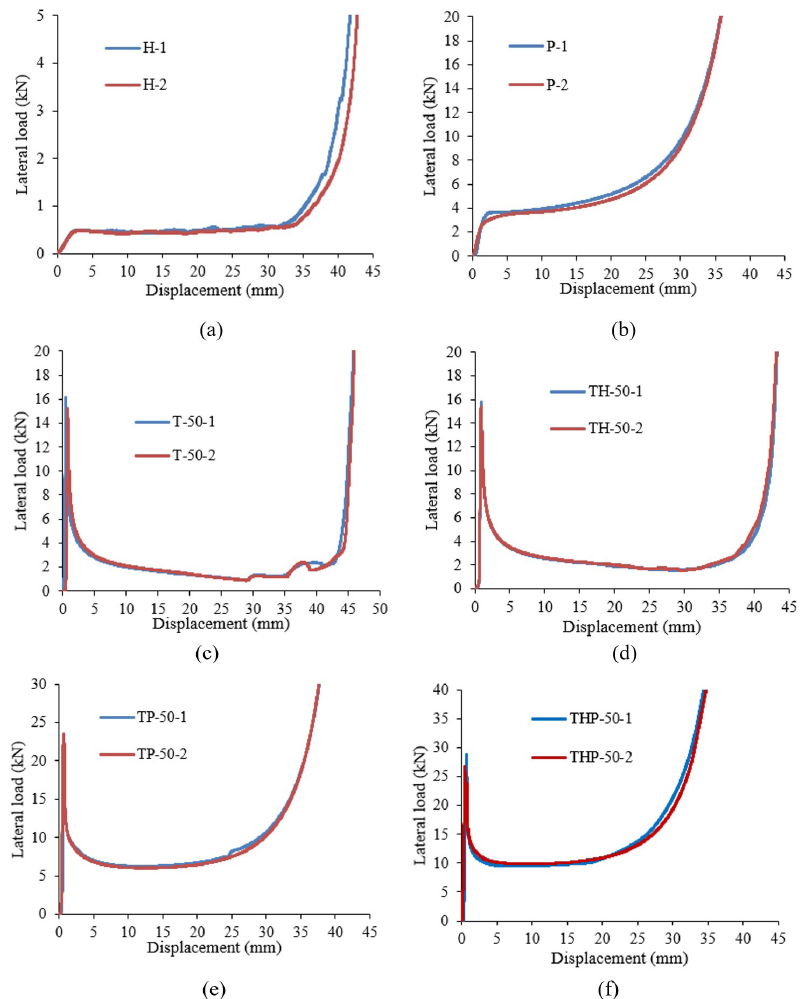
Figure 11. Typical lateral crushing load-displacement curves of: (a) honeycombs; (b) polyurethane foam; (c) hollow tubes; (d) honeycomb- filled tubes; (e) foam-filled tubes; (f) honeycomb and foam filled tubes.